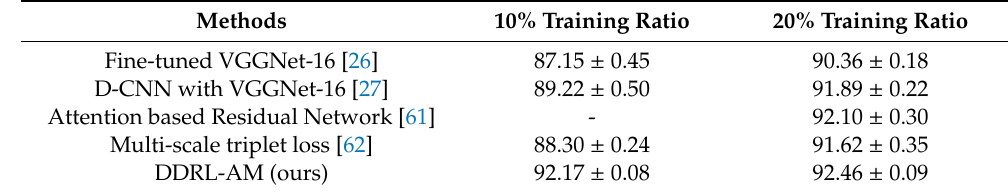
Table 3. Scene classification results (ac% ± std) using the nwpu-resisc45